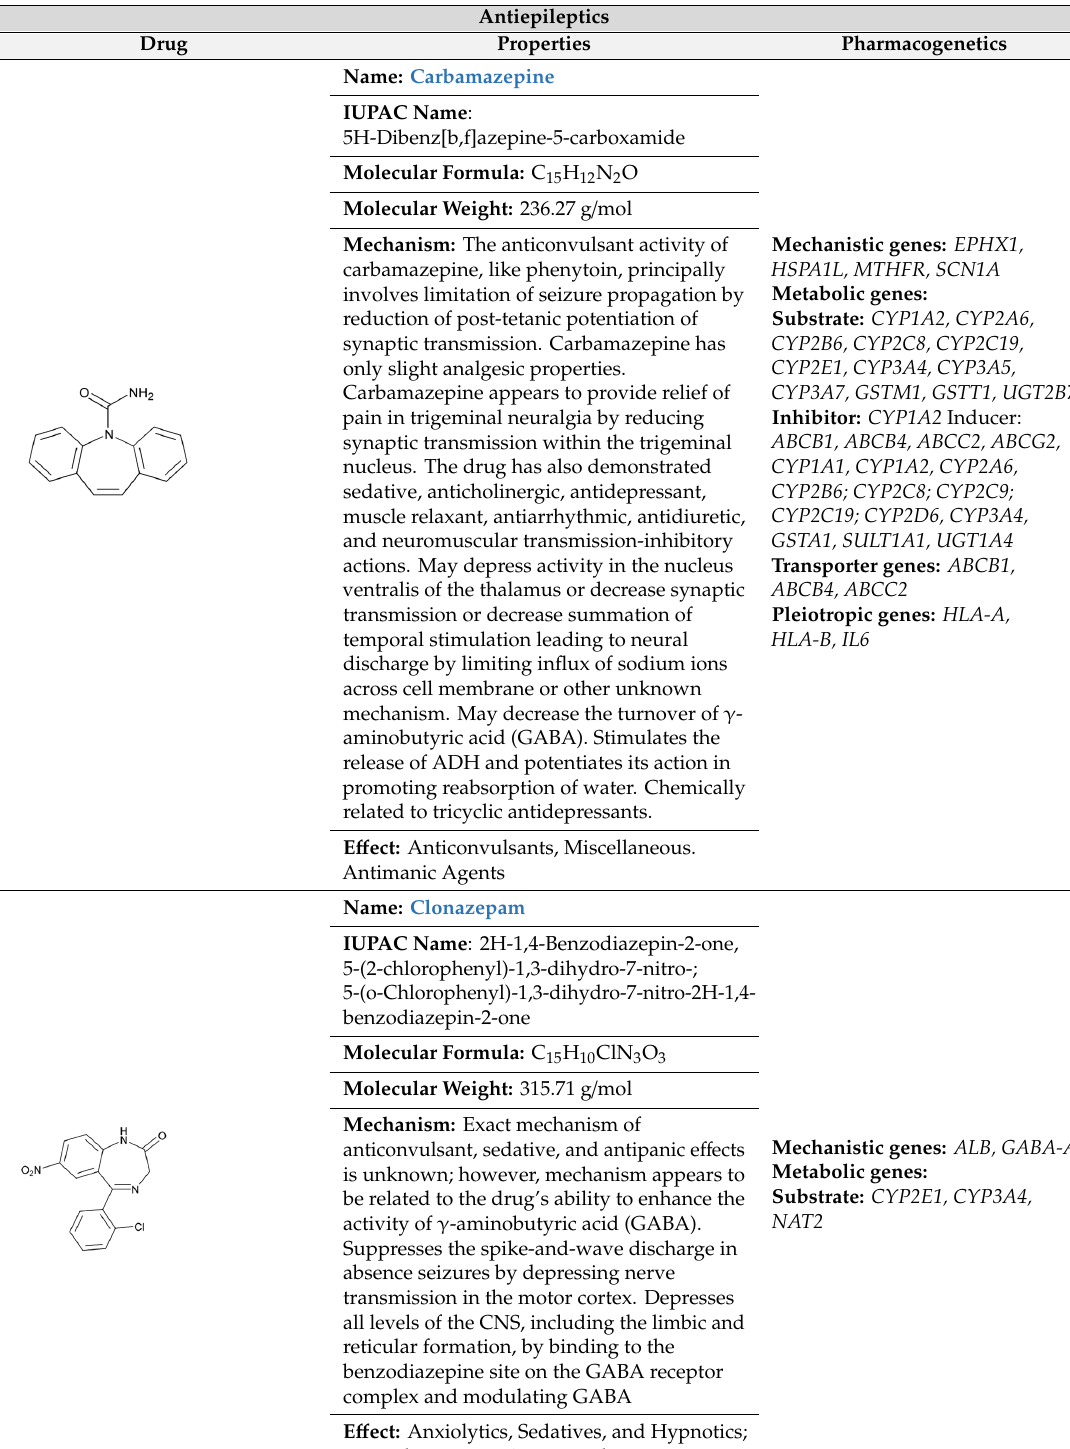
Table 6. Pharmacological properties and pharmacogenetics of selected antiepileptic drugs.